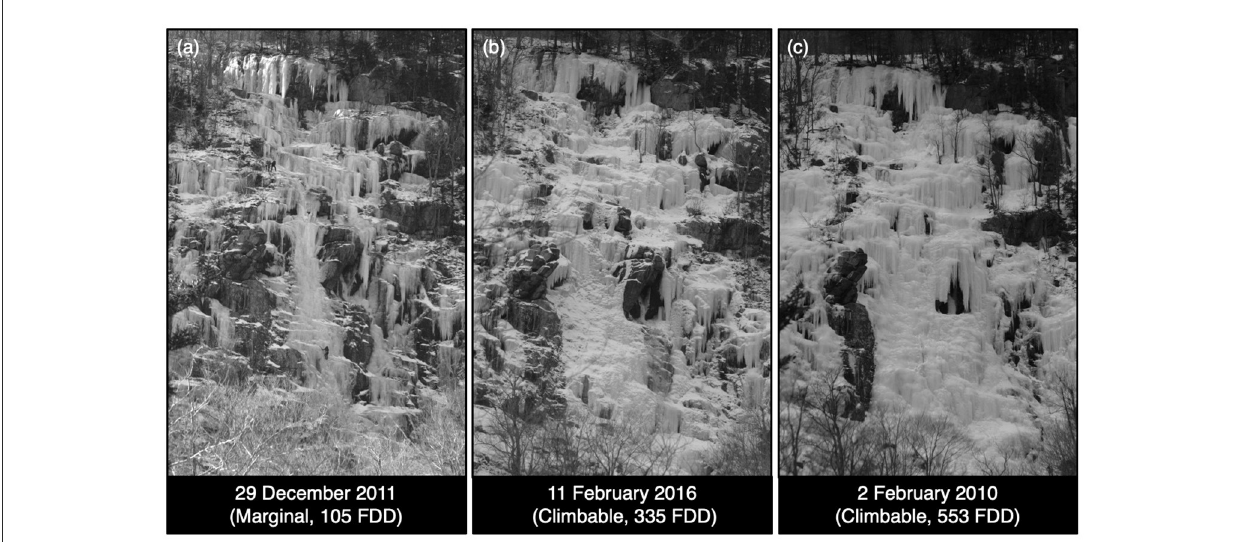
FIGURE6 Analogs for ice formation between 2079 and 2099 under different scenarios based on AFDD values. (a) An AFDD of 105C degree-days occurred in December of the 2011/2012 season and Standard Route was rated ‘marginal’ in this condition. If future seasons yield multiple cold periods with AFDD of ∼ 100C degree-days, interspersed by melting periods with total ice collapse, Standard Route may exist in this condition throughout winter. (b) An AFDD of 335C degree-days occurred in February of the 2015/2016 season. This condition is consistent with the median AFDD expected under